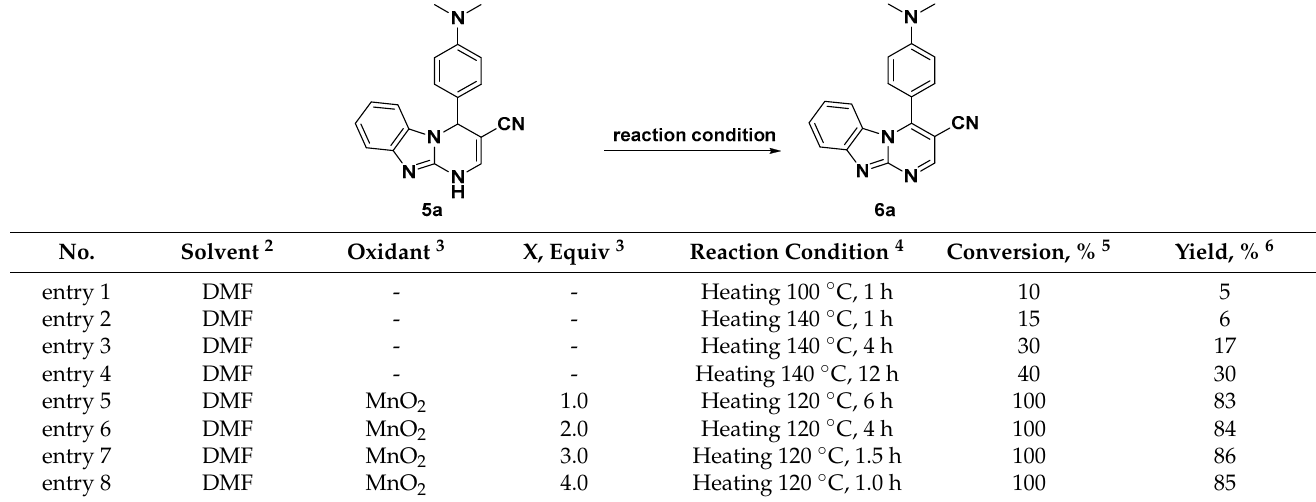
Table 2. Optimization of the oxidation reactions for dihydropyrimidin 5a